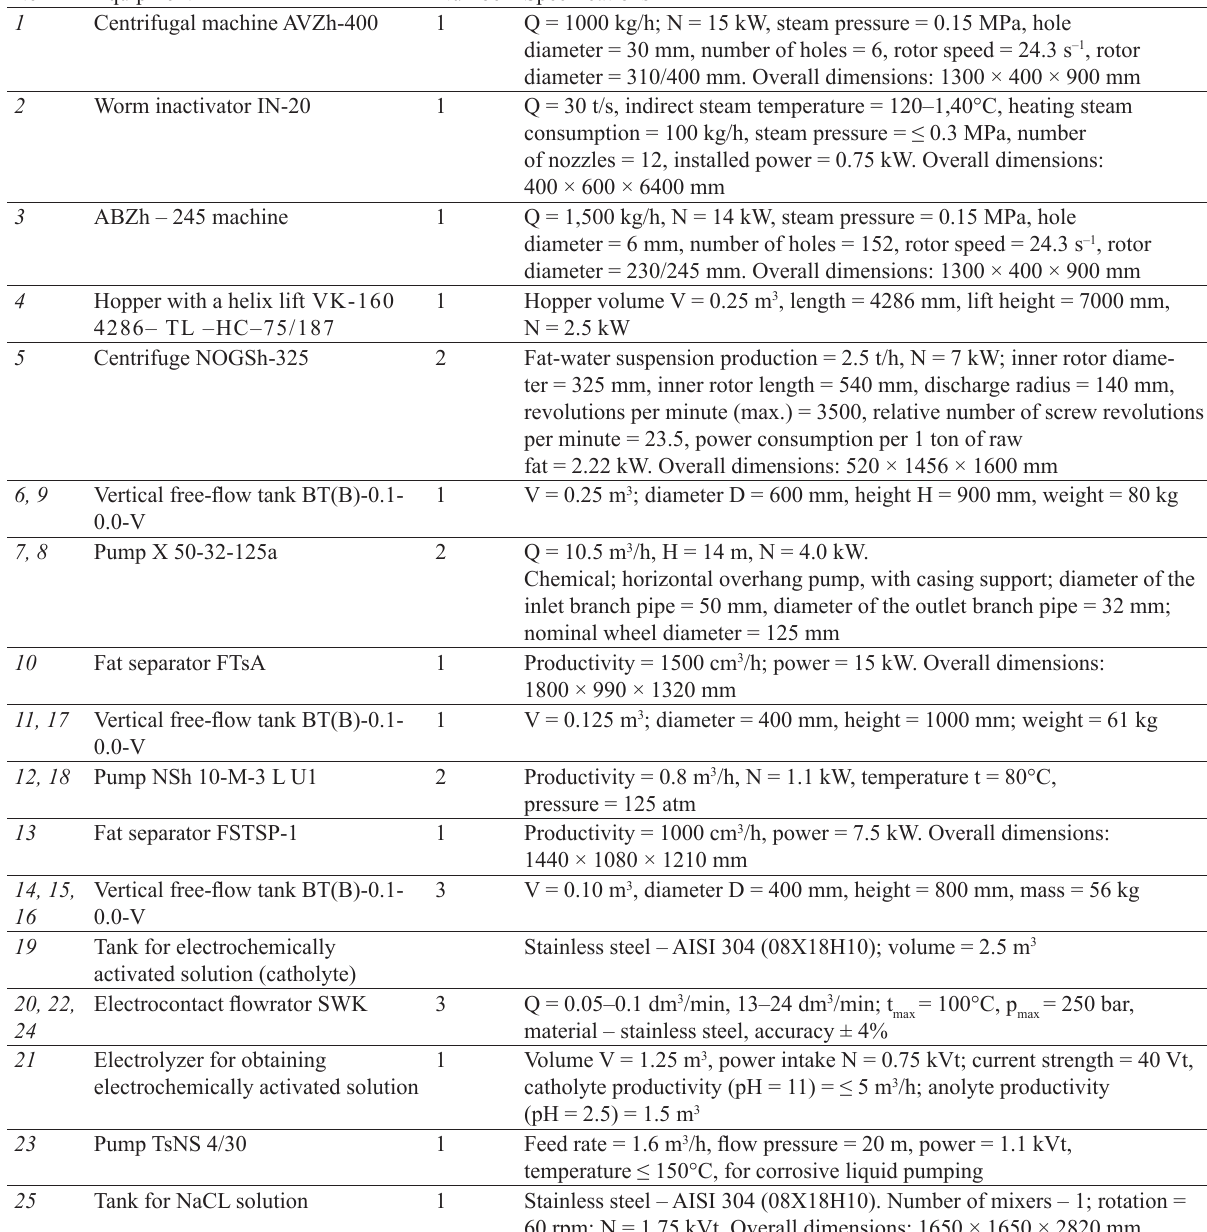
Table 7 List and technical sepcifications of ostrich fat production equipment Item Equipment Number